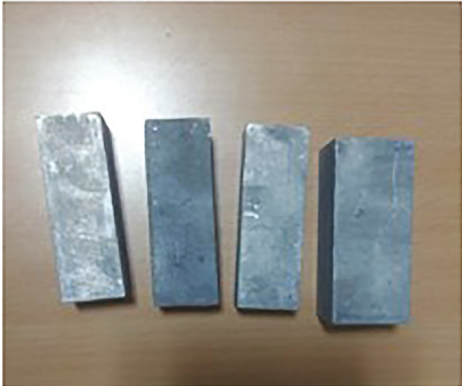
Figure 4: Aluminum 7075 material.